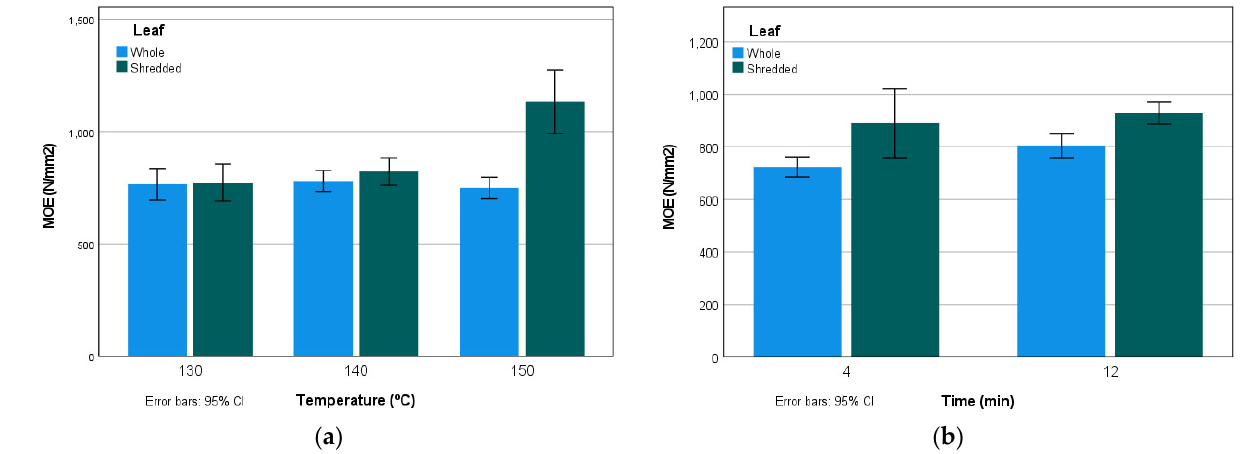
Figure 8. Modulus of elasticity (MOE) according to ( a ) temperature and ( b ) pressing time.